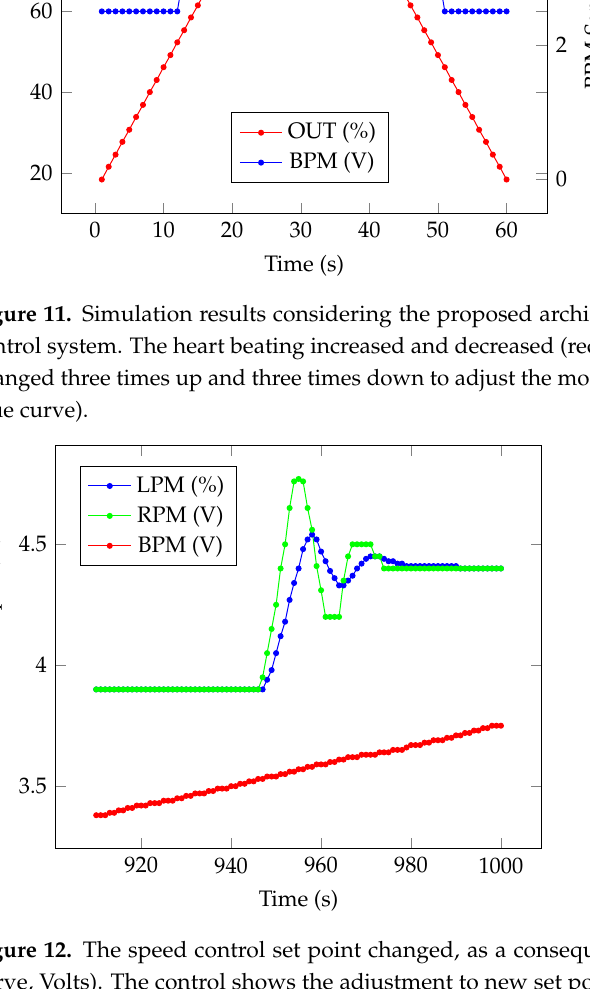
Figure 12. The speed control set point changed, as a consequence of the heart beat increase (red curve, Volts). The control shows the adjustment to new set point. The control algorithm increases the motor rotation (blue curve, %). The increase in the motor rotation increase the blood flow (green curve, Volts). This graph is a detail of a set point change, which happened in Figure